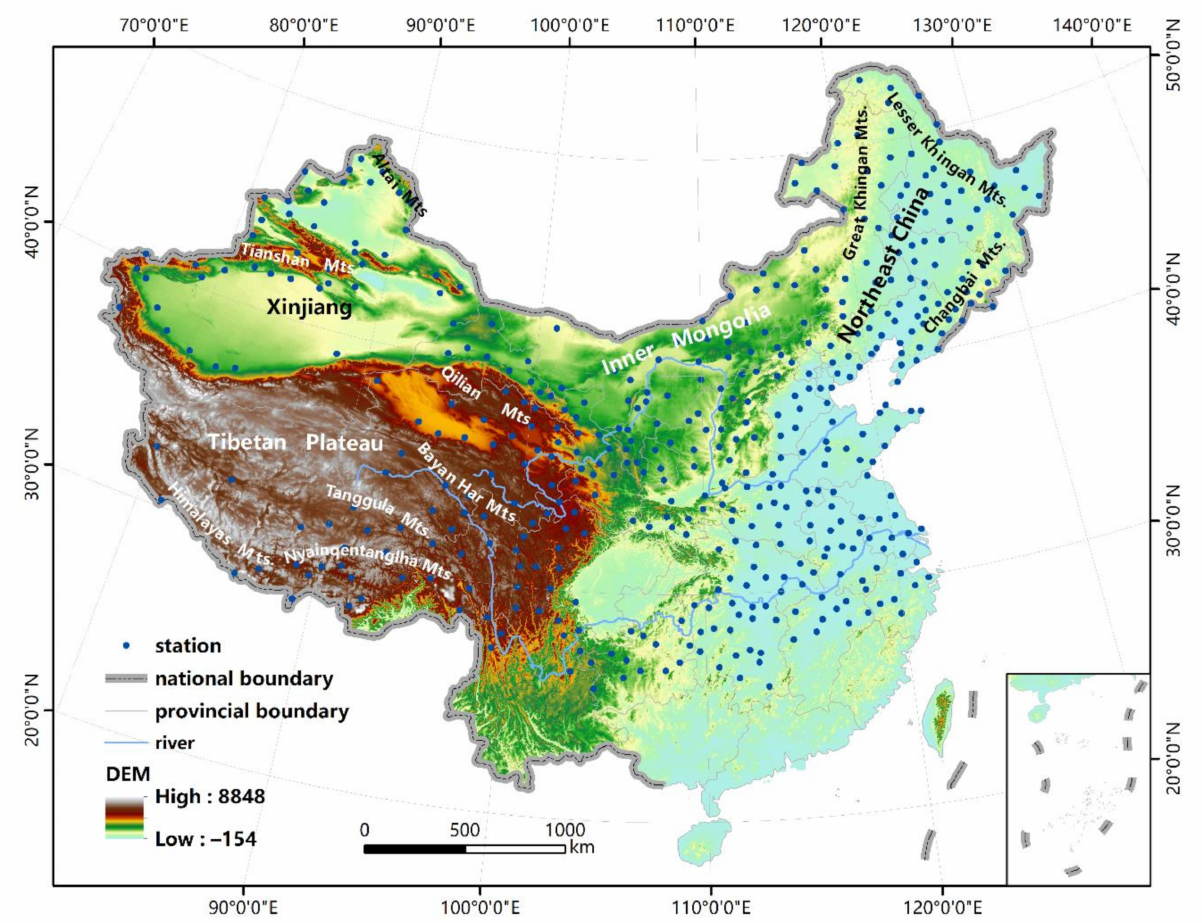
Figure 1. Geographical locations of 452 meteorological stations across